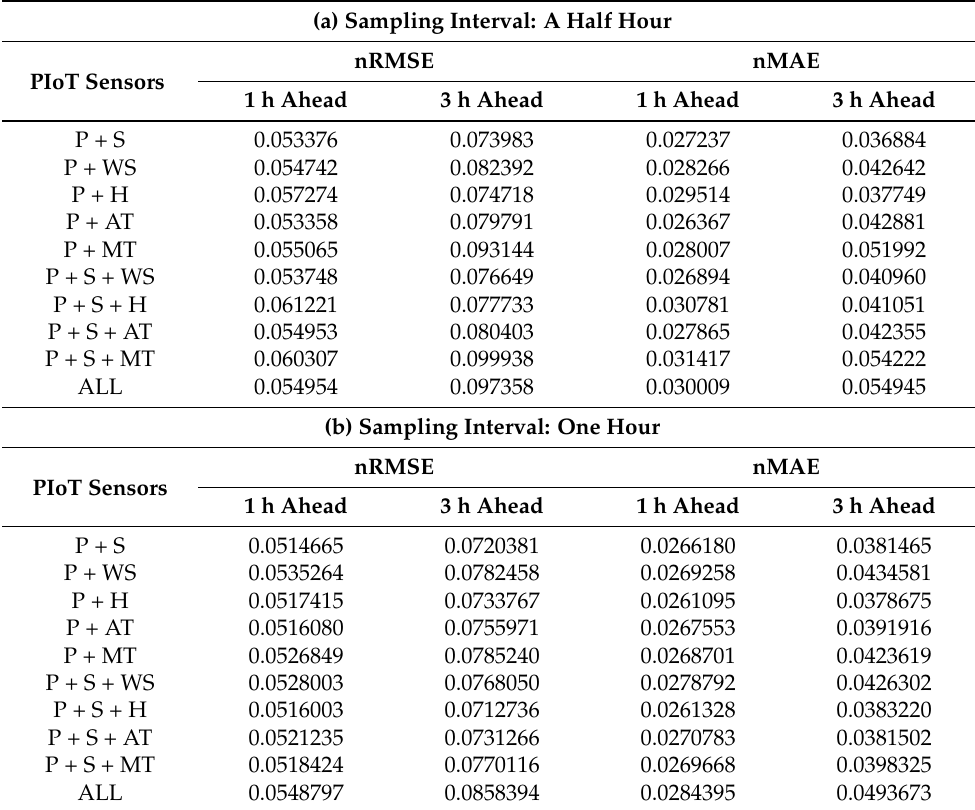
Table 7. Short-term forecasting errors according to PIoT sensors.